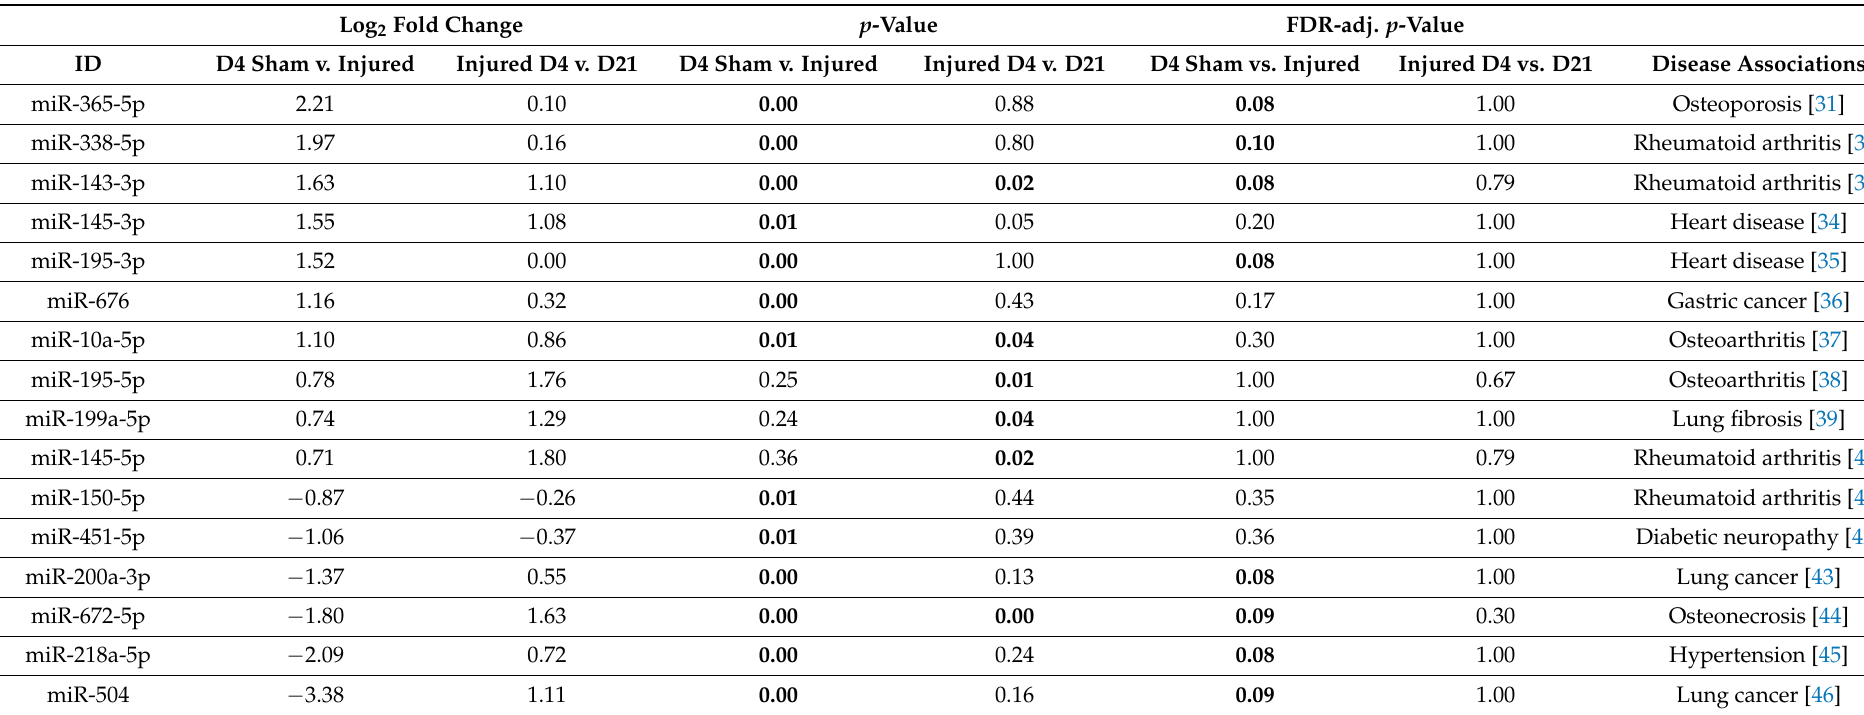
Table 1. Serum miRNAs differentially expressed between sham and injured tendons at day 4, and injured tendons at day 4 and day 21. p -values < 0.05 and FDR-adjusted p -values < 0.1 are displayed in